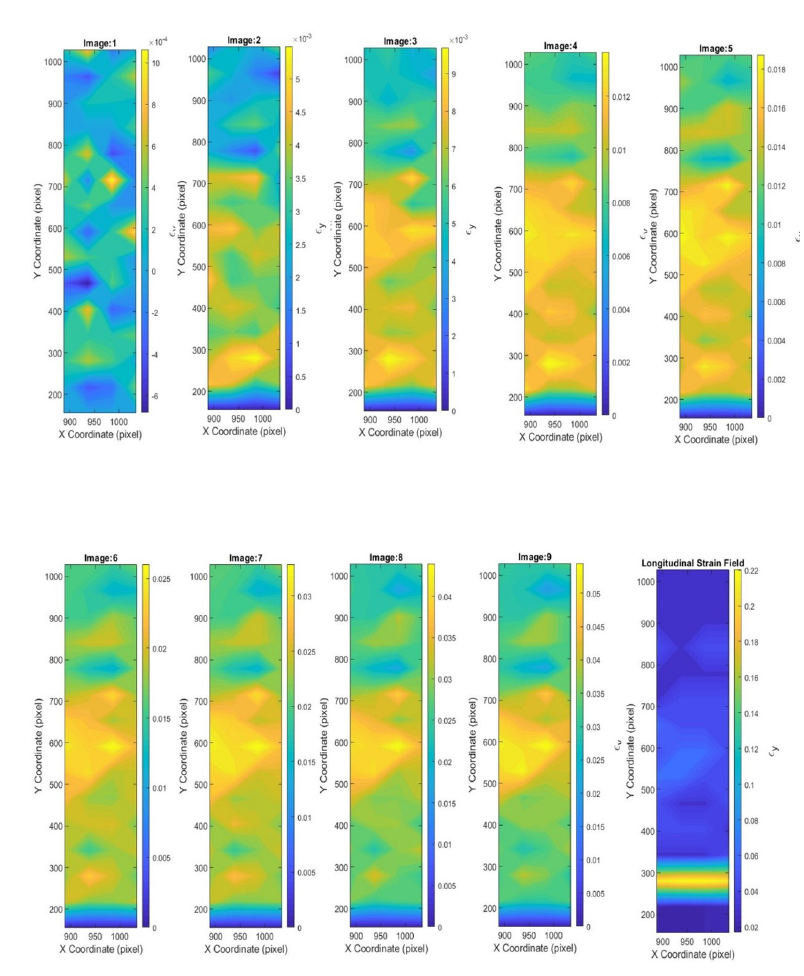
Figure 10. Partial longitudinal strain fields obtained by means of DIC for the test under traction of the specimen